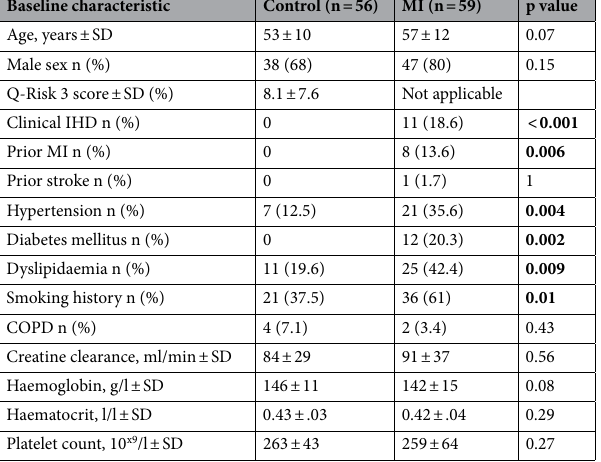
Table 1. Summary of baseline characteristics for the healthy control and acute MI populations. Bold values are statistically significant (p < 0.05). IHD ischaemic heart disease, MI myocardial infarction, COPD chronic obstructive pulmonary